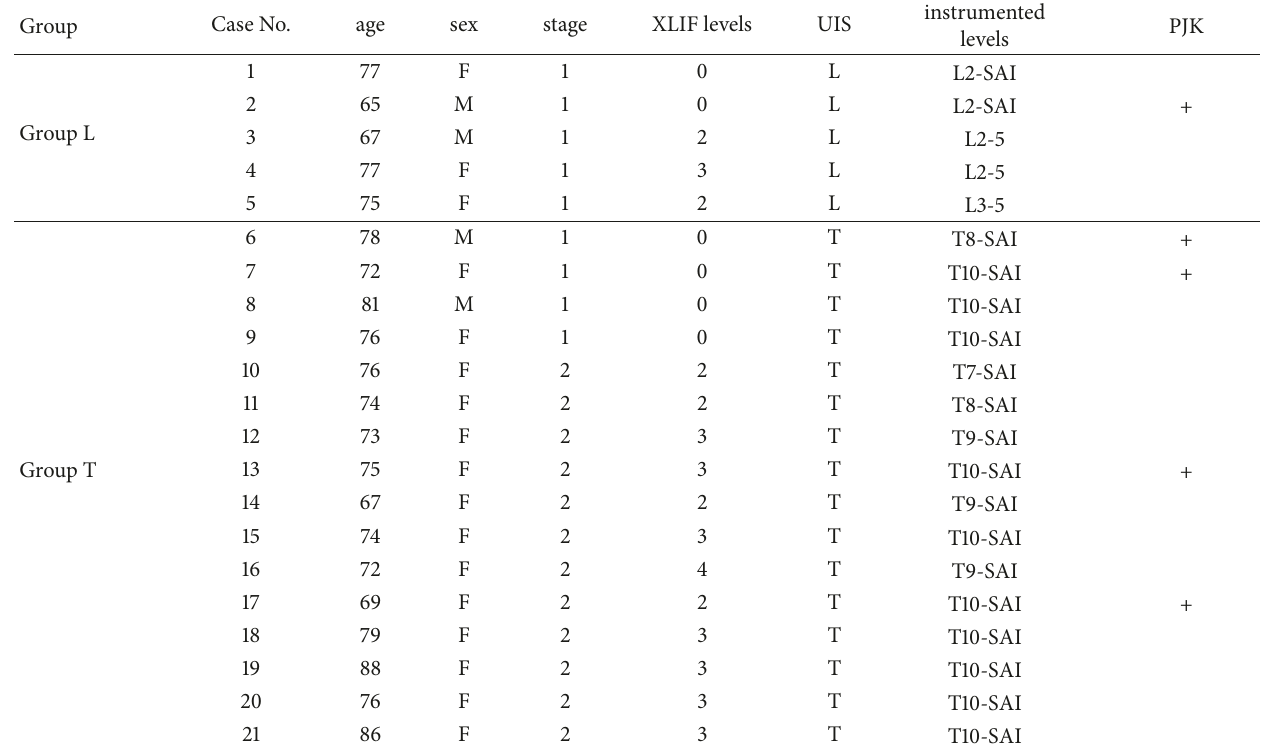
Table 1: Case summaries.